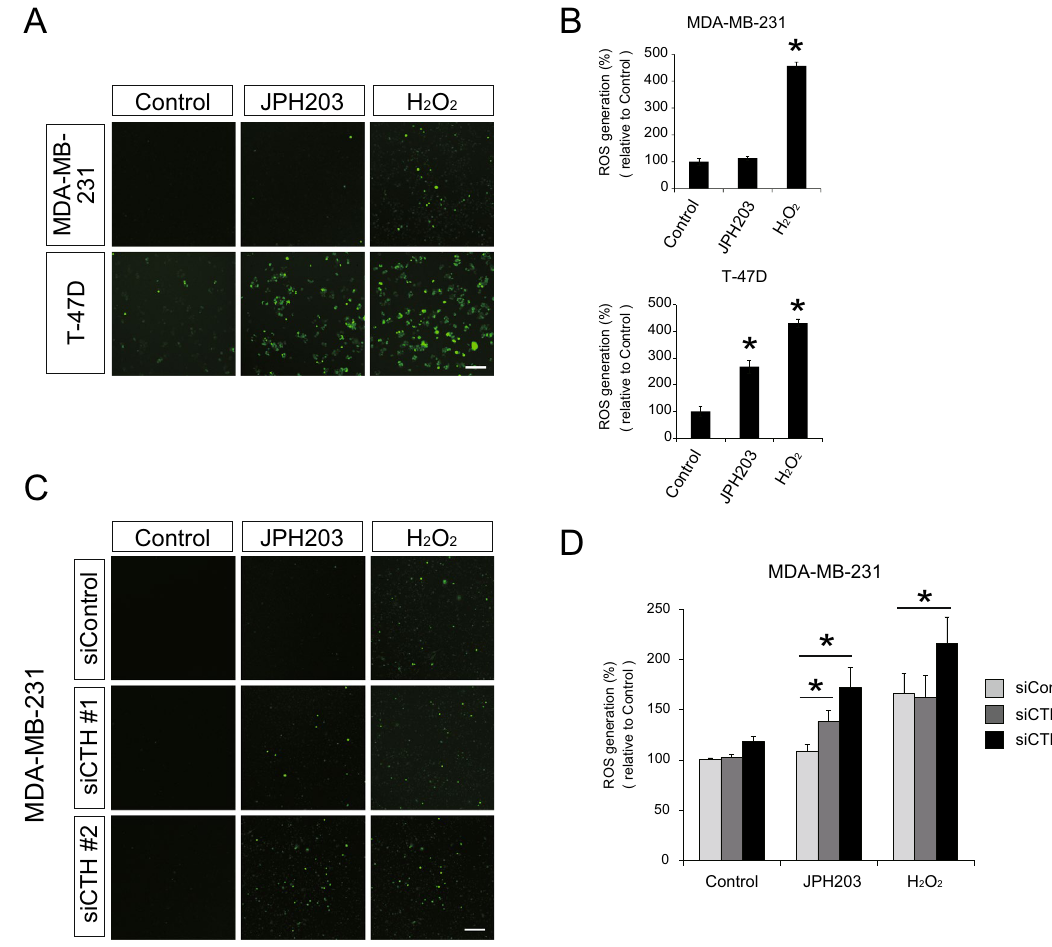
Figure 5. Cellular reactive oxygen spices (ROS) levels in response to JPH203 treatment. ( A ) Cell-permeable fluorogenic dye, DCFH-DA, was used to observe cellular ROS level after treatment with 100 μM JPH203 for 48 h in MDA-MB-231 and T-47D cells. Hydrogen peroxide treatment for 20 min was used as positive control. Scale bar = 100 μm. ( B ) Fluorescence intensity of ( A ) was measured by micro plate-reader. *p < 0.05. ( C ) MDA-MB-231 cells were transfected with control (scrambled) or CTH siRNA followed by incubation in the absence or presence of 100 μM JPH203 for 48 h. Cellular ROS levels were measured with DCFA-DA. Hydrogen peroxide treatment for 20 min was used as positive control. Scale bar = 100 μm. ( D ) Fluorescence intensity of ( C ) was measured by micro plate-reader. *p <